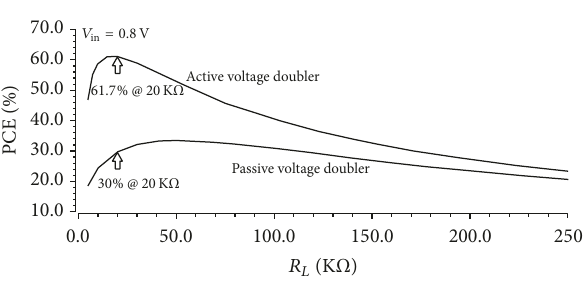
Figure 7: Simulated voltage waveforms when 𝑉 in = 0.8 V.